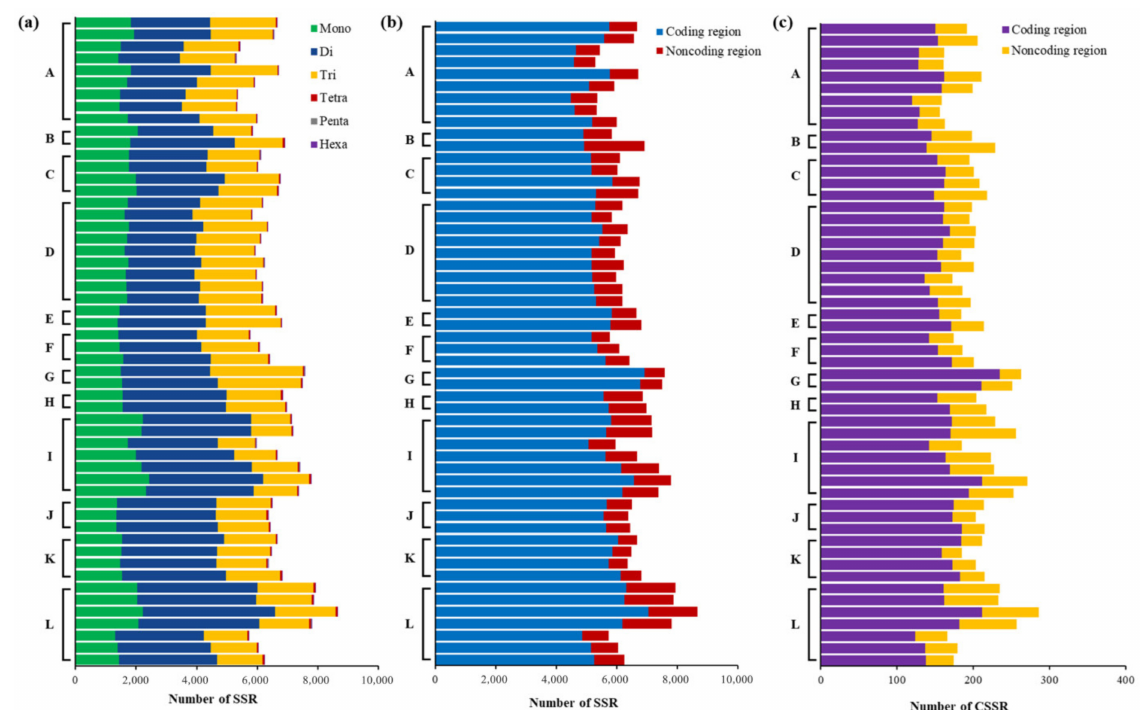
Figure 4. The SSR and CSSR distribution patterns of 54 Parasynechococcus -like strains genomes: ( a ) distribution according to SSR repeat type; ( b ) SSR distribution according to coding and non- coding regions; and ( c ) CSSR distribution according to coding and non-coding regions. Data were presented by the subclades (A–L) identified in Figure